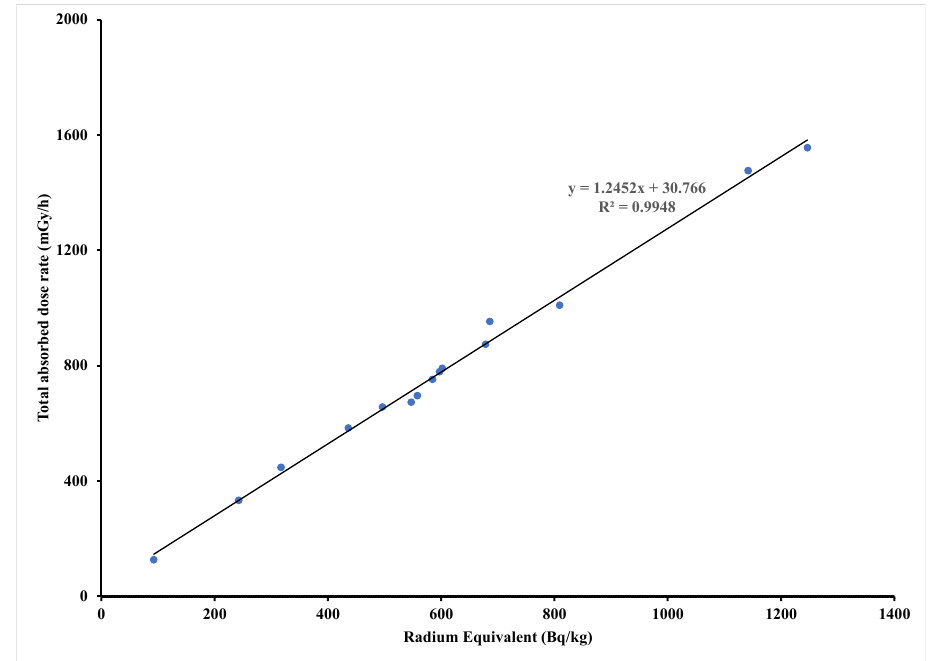
Figure 4. Correlation between absorbed dose rate and radium equivalent.